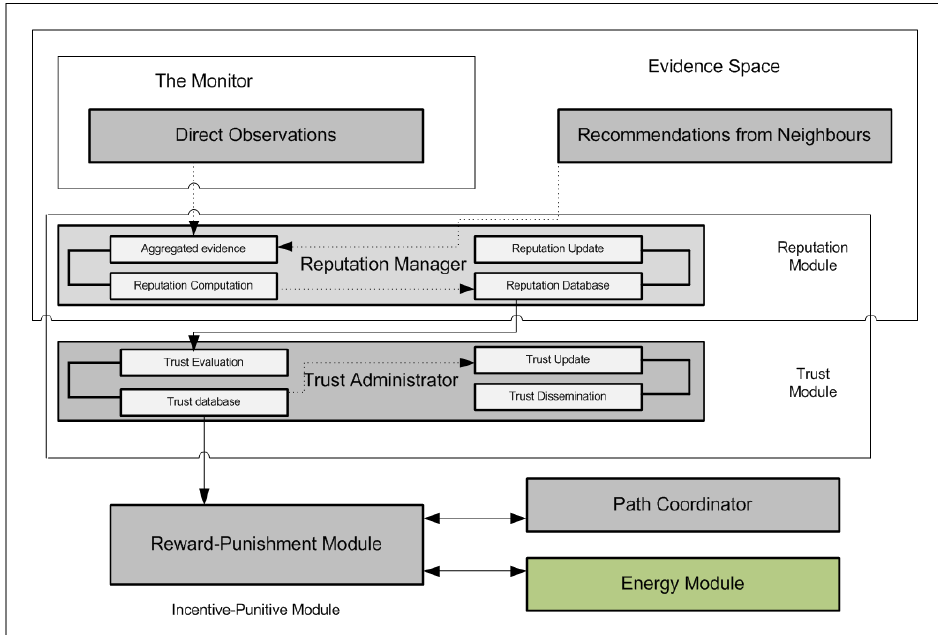
Figure 2. The schematic diagram of the Dirichlet Reputation and Trust Management System.